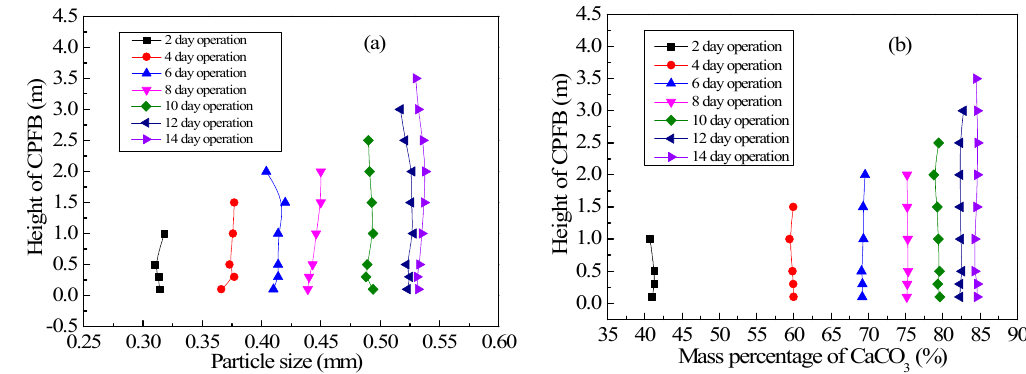
Figure 4. ( a ) Granularity distribution and ( b ) the mass percentage of CaCO 3 at different heights of the CPFB reactor.